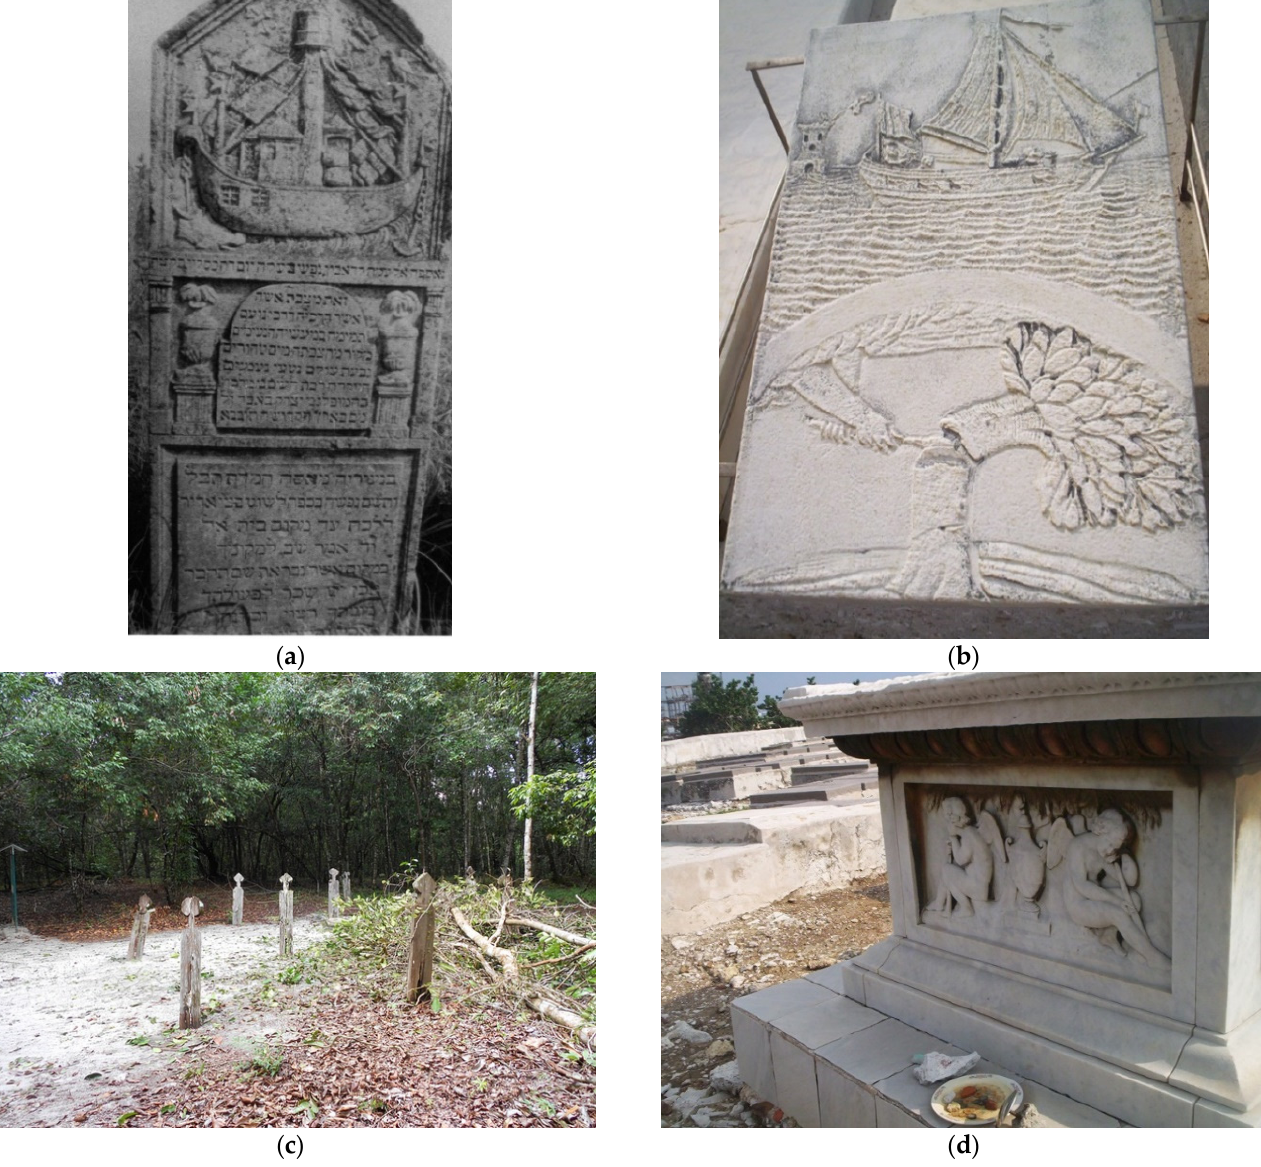
Figure 2. ( a ) Malka Babad’s gravestone (Brody, 1837). ( b ) A Jewish gravestone with an image of a ship in Curaçao. ( c ) Creole cemetery in Jodensavanne, Suriname. ( d ). In Curaçao, the old Jewish cemetery, according to the leader of the local Jewish community, Rene Maduro, in some cases became a place of voodoo rituals (Figure 2d, taken by the author in 2006).